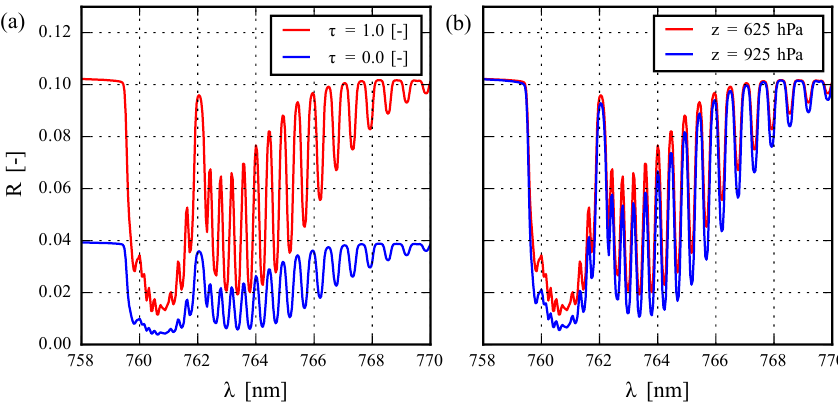
Figure 1. Synthetic oxygen A-band spectra for a cloudless atmosphere containing aerosols over a surface with an albedo of 0.03, as measured by a nadir pointing instrument for a solar zenith angle at 45 ◦ . The instrument settings are that of the UVN instrument. Aerosol single- scattering albedo is fixed at 0.95 and scattering by aerosols is described by a Henyey–Greenstein phase function with an asymmetry factor ( g ) of 0.7. (a) Aerosol layer is fixed at a height of 900–950hPa, for two scenes are different aerosol optical thicknesses. (b) Aerosol vertical distribution is varied for an aerosol optical thickness of 1.0 at